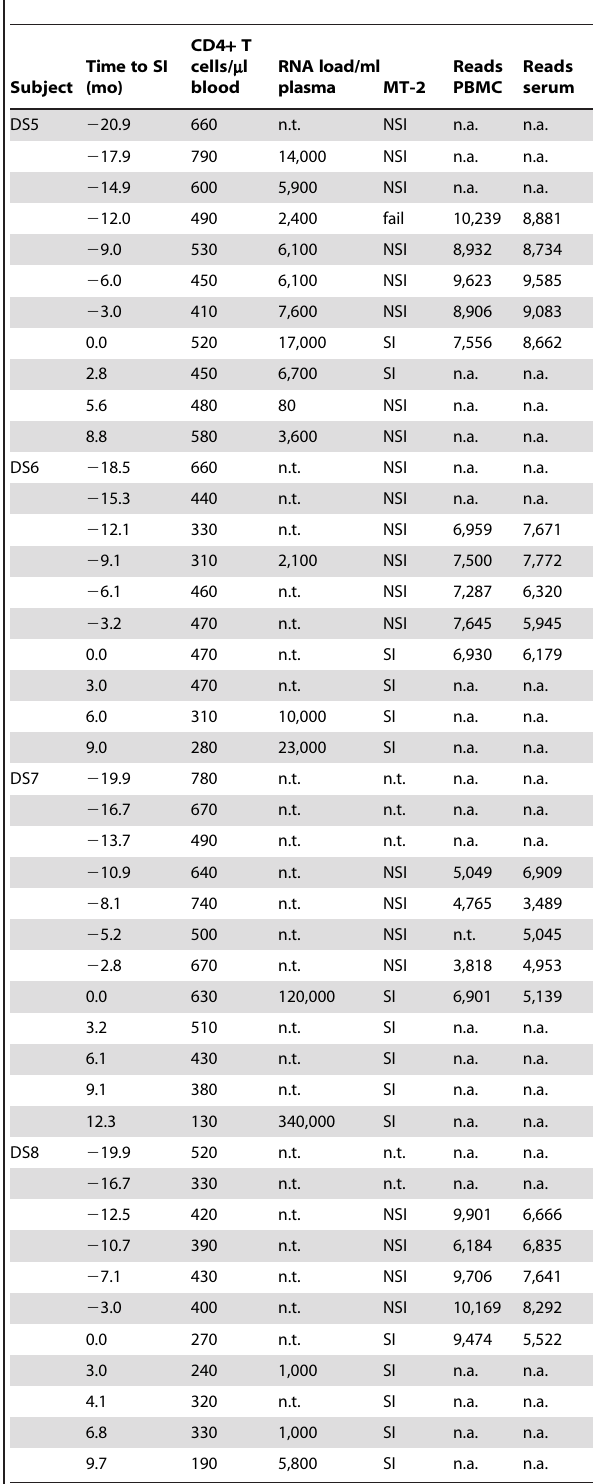
Table 3. CD4 + T cell counts, viral load and MT-2 assay results of participants DS5–DS8 around and during the period of